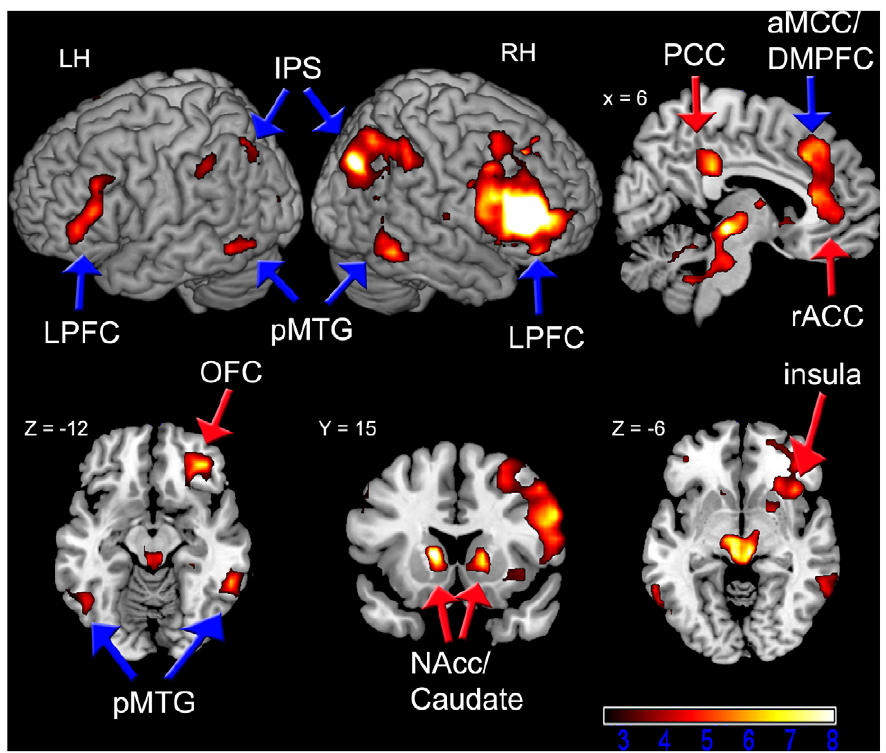
Figure 4. Regions Exhibiting Functional Connectivity with the IFS Across the Entire Time-Course ( Z . 2.57, p , .05 FWE cluster corrected for the whole-brain). Rule areas (blue arrows) include bilateral lateral prefrontal cortex (LPFC), anterior mid-cingulate cortex/ dorsomedial prefrontal cortex (aMCC/DMPFC), posterior middle temporal gyrus (pMTG), and intraparietal sulcus (IPS). Reward areas (red arrows) include rostral anterior and posterior cingulate cortices (rACC, PCC), orbitofrontal cortex (OFC), caudate/nucleus accumbens (NAcc), and insula. The color scale denotes t-values, and the numerical values above the images correspond to MNI coordinates. For axial and coronal slices, the right hemisphere is on the right side of the image. LH=left hemisphere, RH=right